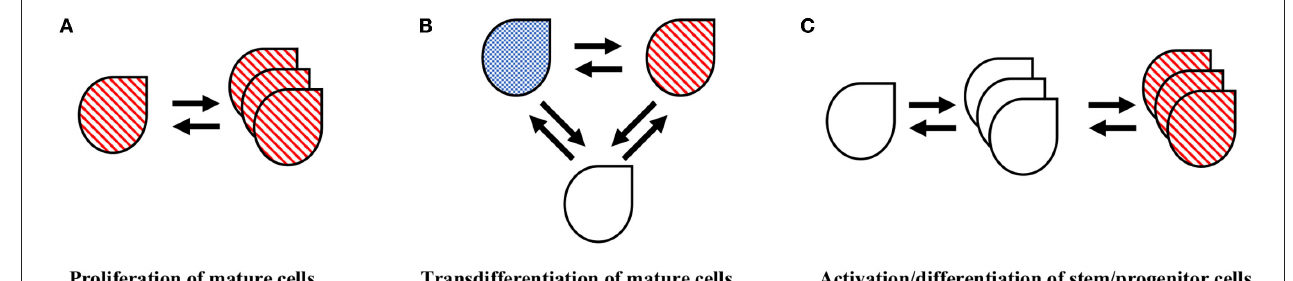
FIGURE 2 | Cellular mechanisms that may contribute to pituitary population restructuring. There is evidence that pituitary populations undergo restructuring through multiple cellular mechanisms including (A) mitotic proliferation of existing hormone cells, (B) transdifferentiation of mature hormone cells and (C) activation and differentiation of stem/progenitor cells. The double arrows imply a potential reversibility of these cellular processes. See text for details and relevant